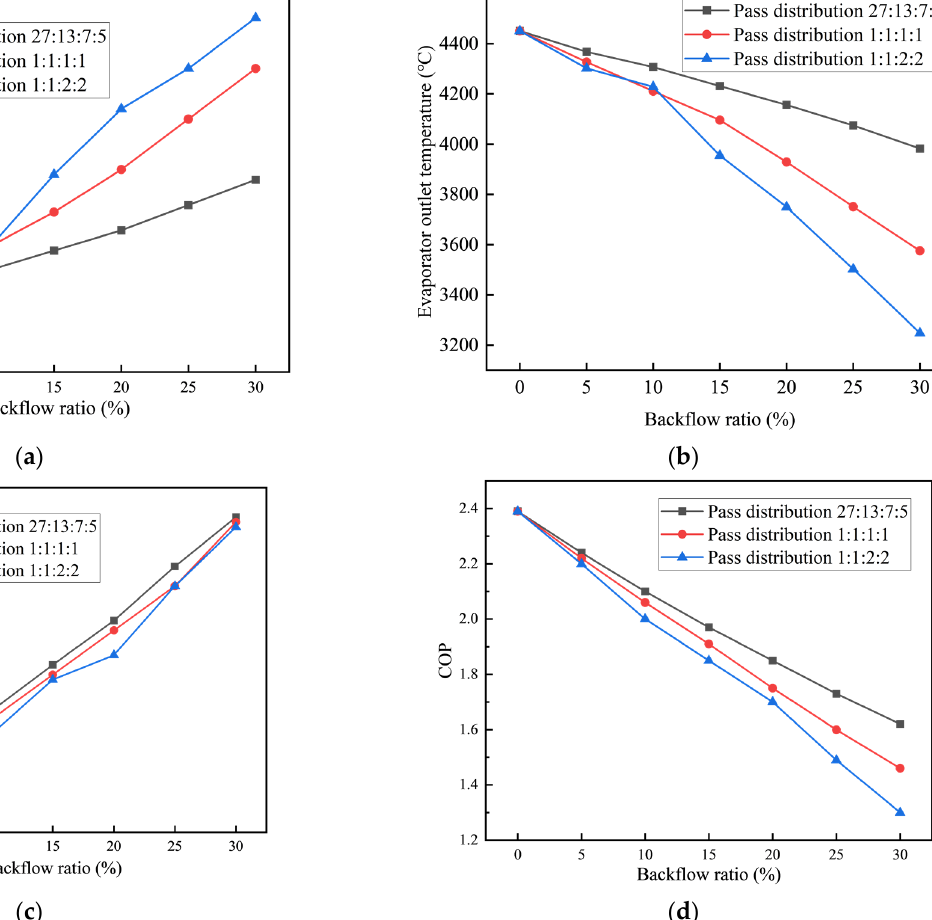
Figure 8. Influences of the backflow rate on air conditioning performances under different ambient temperatures. ( a ) Evaporator exit temperature; ( b ) evaporator heat rejection; ( c ) discharge pressure; and ( d ) COP.